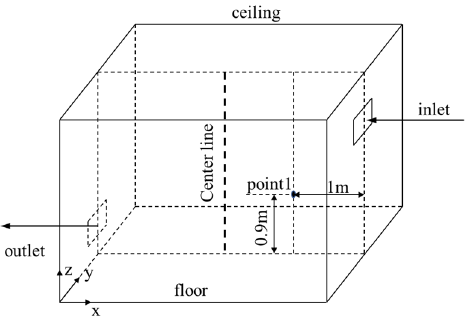
Figure 7. Time variation of particle-number density at point 1 for 8.5 μ m particles.